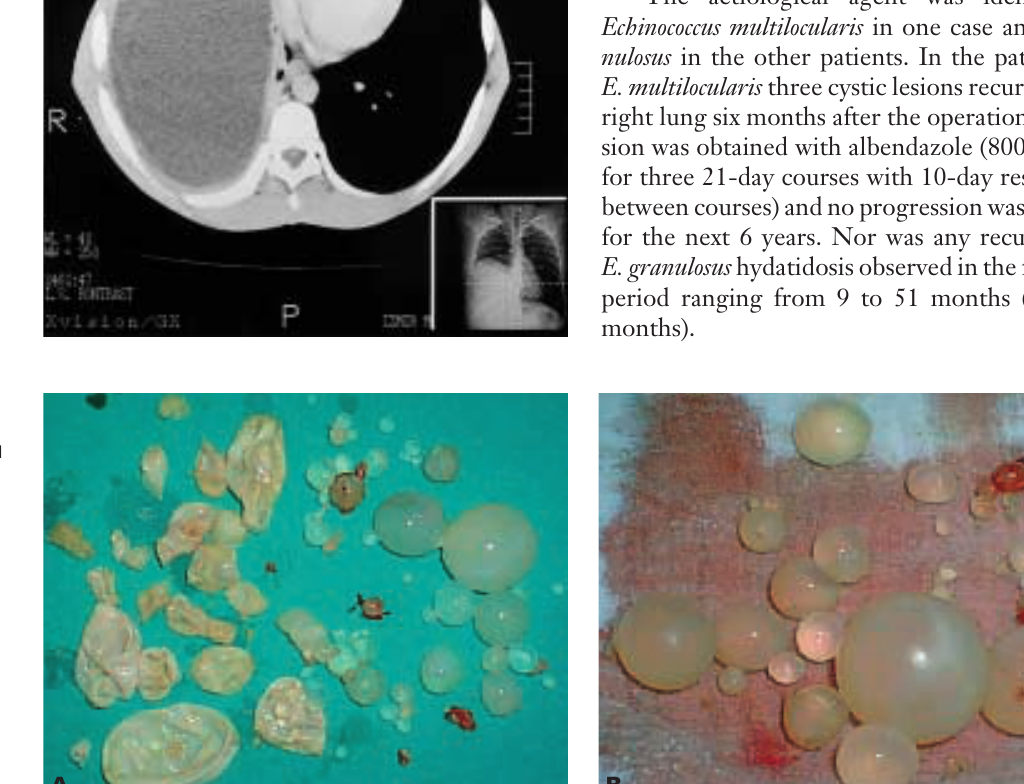
Computed tomo- graphy showing giant hydatid cyst.